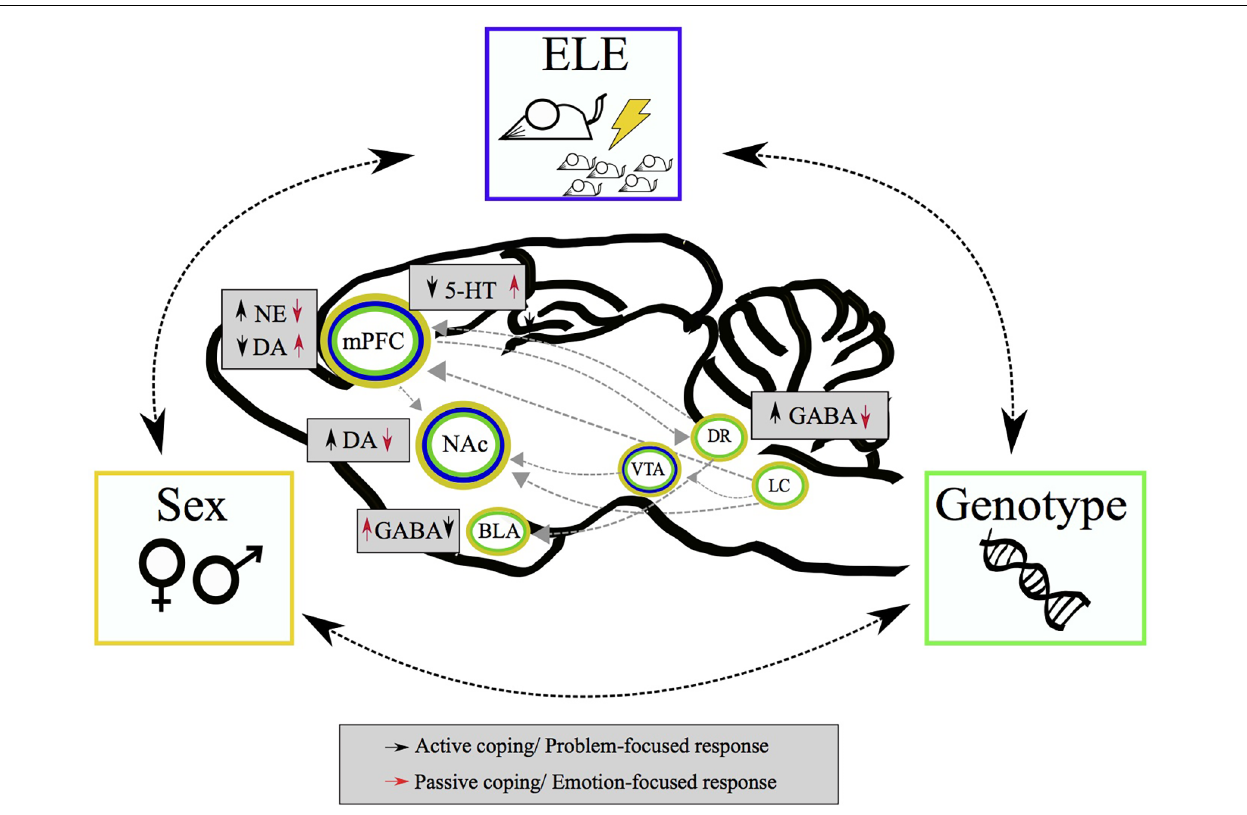
FIGURE 1 | Schematic representation of complex interaction of environmental and individual factors influencing stress coping. Critical experiences in early life, genetic constitutive characteristics, and sex-based differences contribute to coping strategies (i.e., active/passive) mediated by different neurotransmitters balance within mesocorticolimbic circuit and afferent